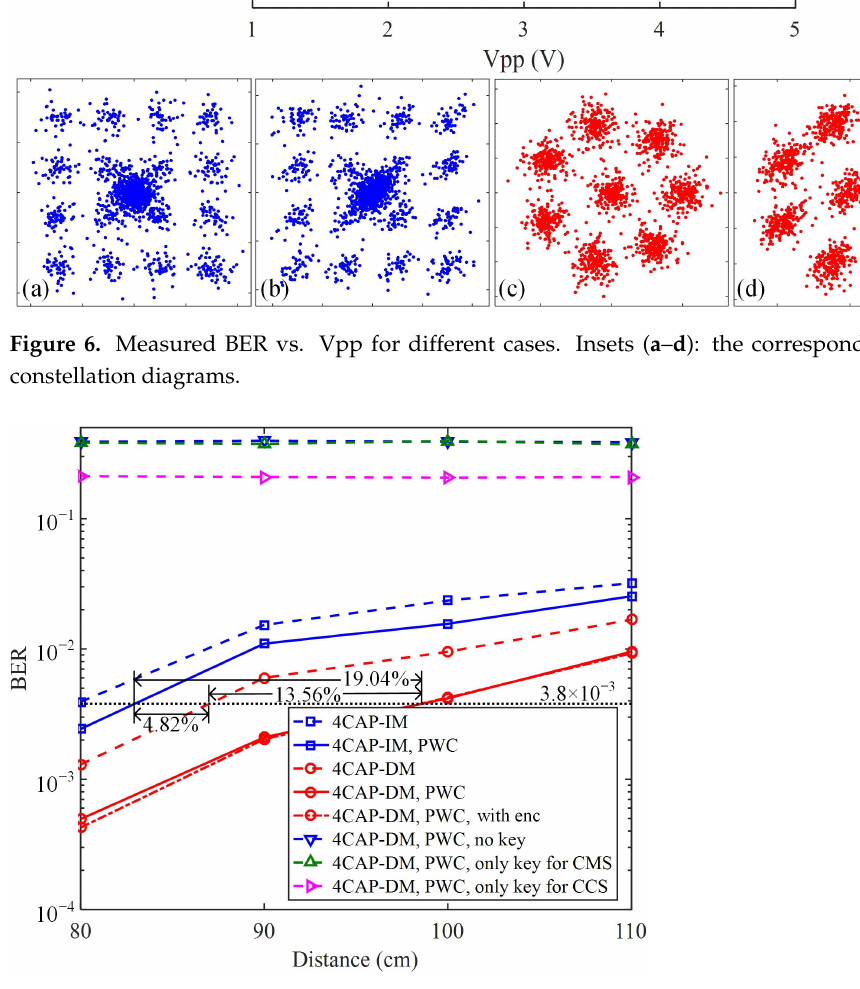
Figure 7. Measured BER vs. transmission distance for different